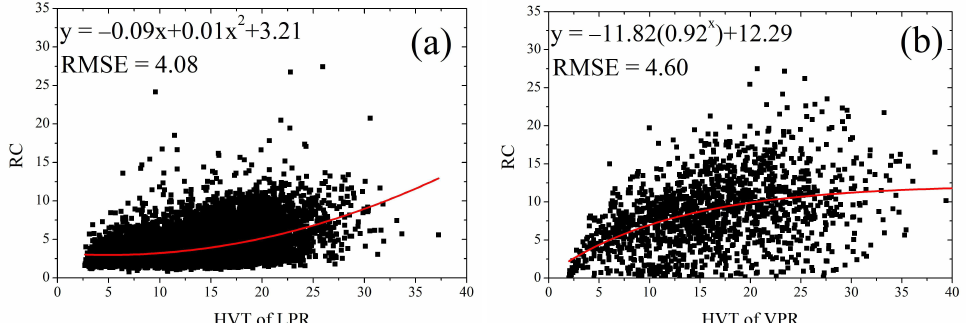
Figure 5. Relationship between HVT and RC driven by LPR ( a ) and VPR ( b ). Red lines indicate linear